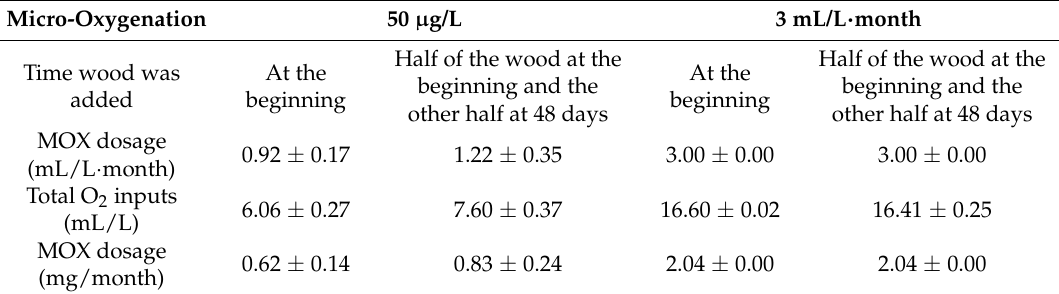
Table 1. Summary of dosages during MOX in the aging tanks tested.